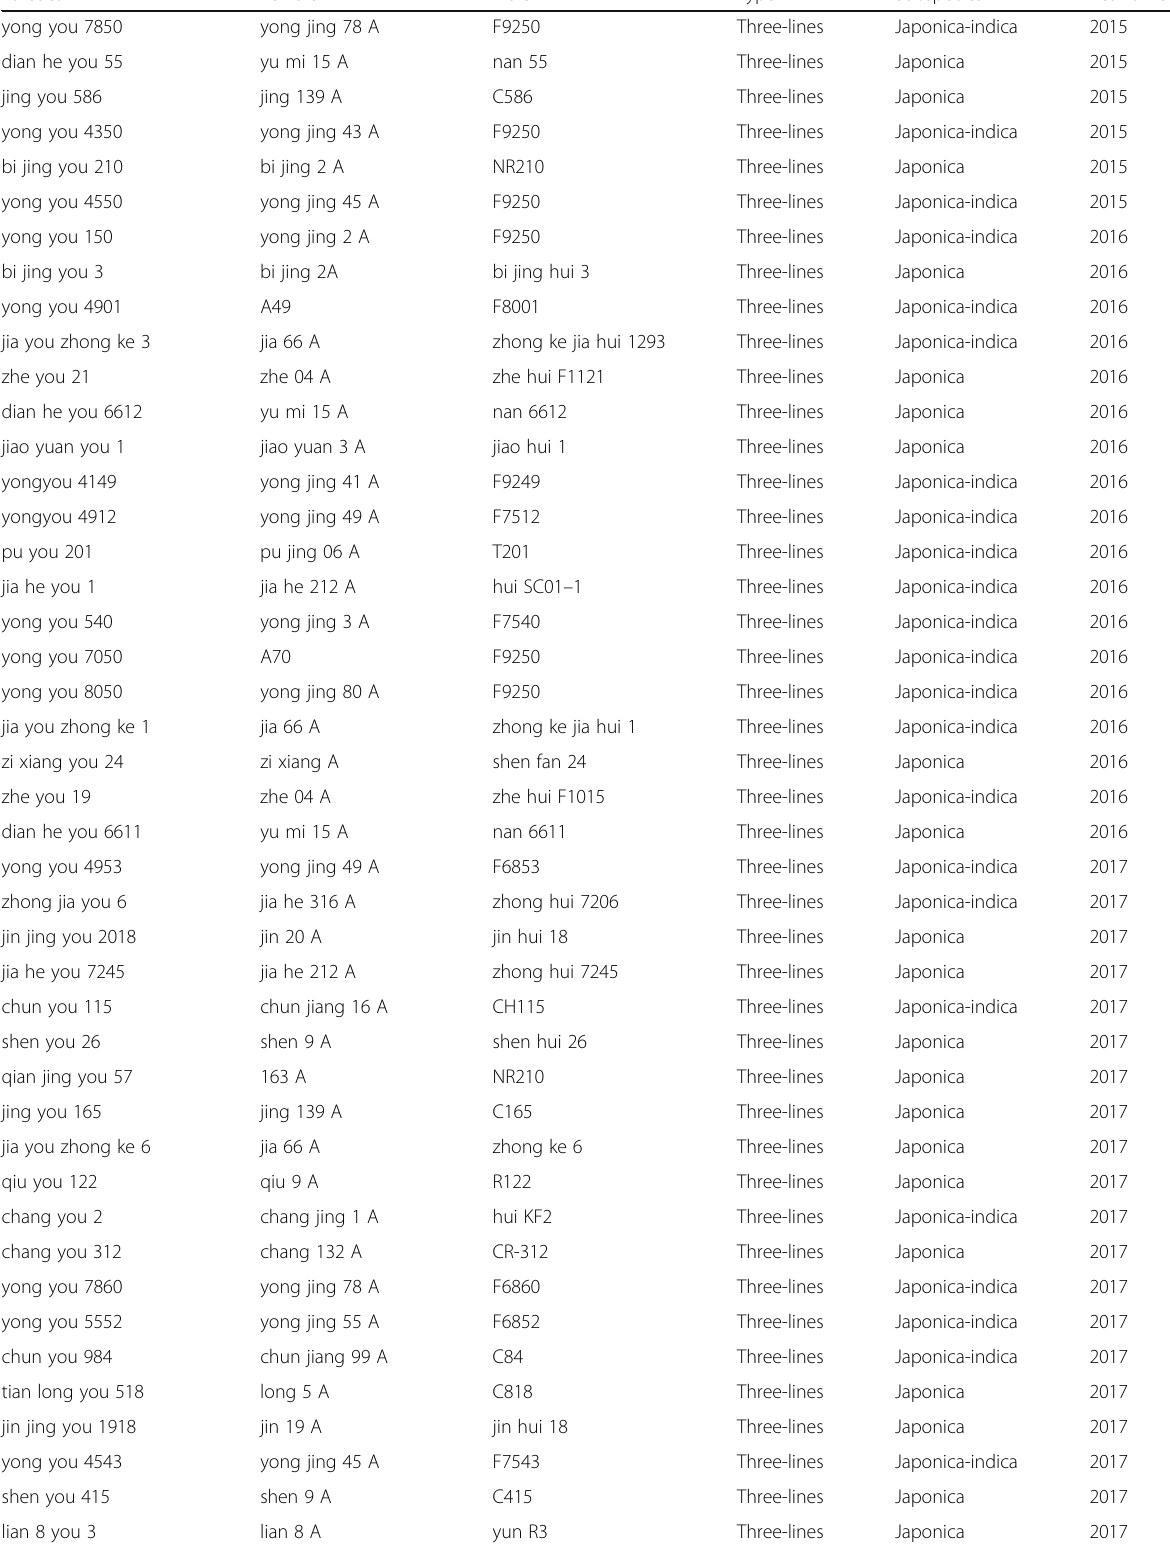
Table 1 List of hybrid japonica rice varieties bred in China (Continued) Vareties